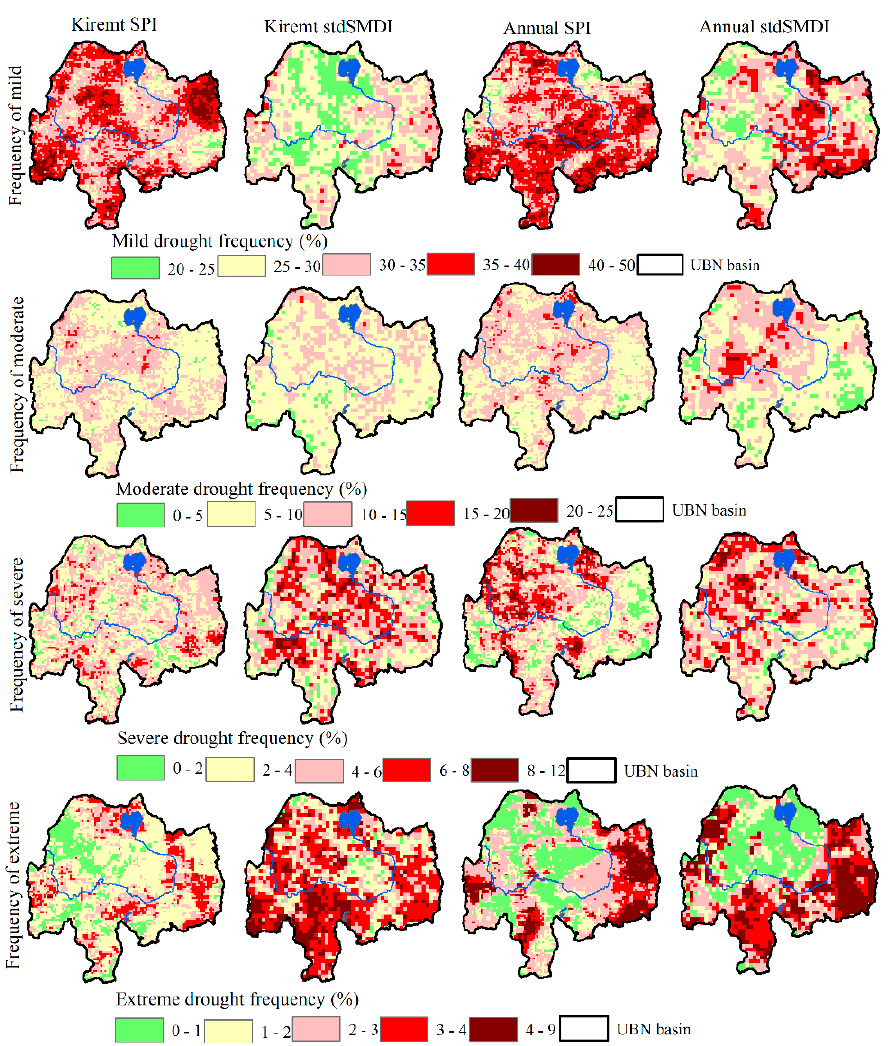
Figure 5. Spatial pattern of frequency of occurrence of mild (top panel), moderate (second panel), severe (third panel) and extreme (bottom panel) meteorological (first and third columns) and agricultural (second and fourth columns) droughts during Kiremt and annual aggregate periods.